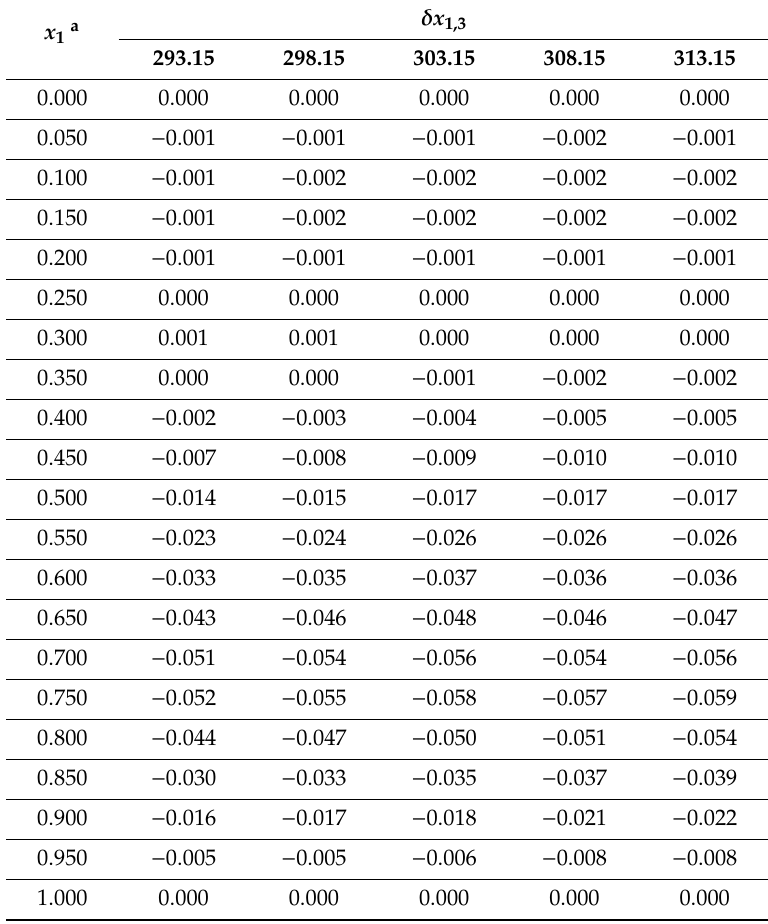
Table 5. The δ x 1.3 values of amygdalin in {ethanol (1) + water (2)} mixtures at some temperatures. x 1